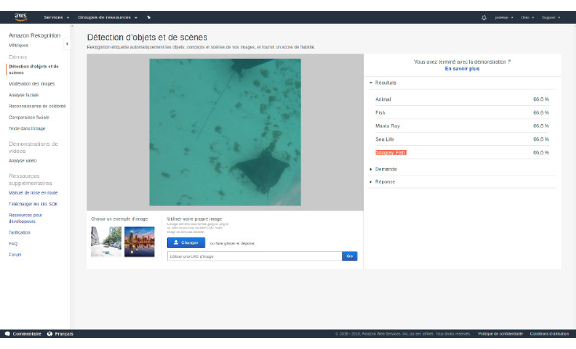
Figure 8. 3D mapping from coral reef images collected from a